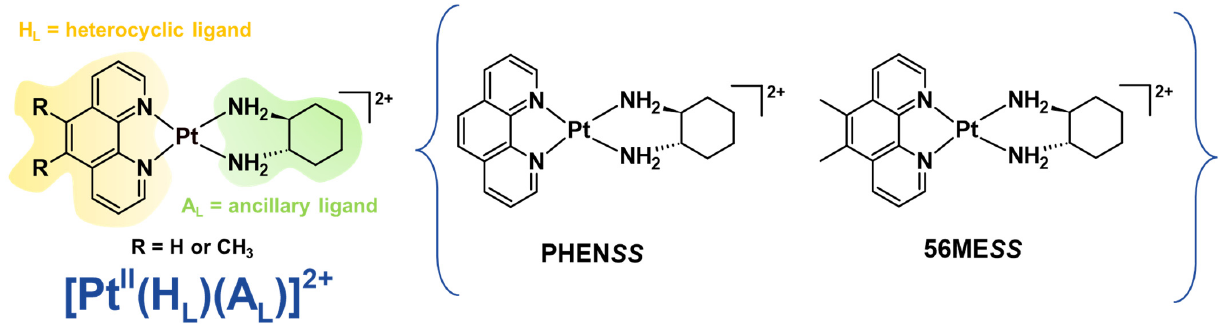
Figure 2. General structures of cytotoxic non-DNA coordinating platinum(II) complexes, PHEN SS and its analogue, 56ME SS .